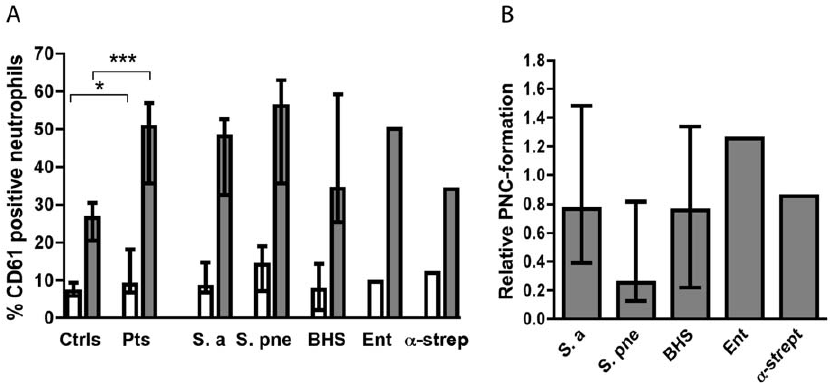
Figure 4. Formation of platelet-neutrophil complexes in healthy controls and in patients. (A) The percentage of PNCs is expressed as the percentage of neutrophils positive for the platelet marker CD61 in response to buffer only (open bars) or ADP/fMLP (grey bars). Values are 6 interquartile range. In (B) the increase in PNCs induced by different bacterial isolates relative to the increase caused by ADP/fMLP is shown. * P , 0.05 and *** P , 0.001 with Mann-Whitney U